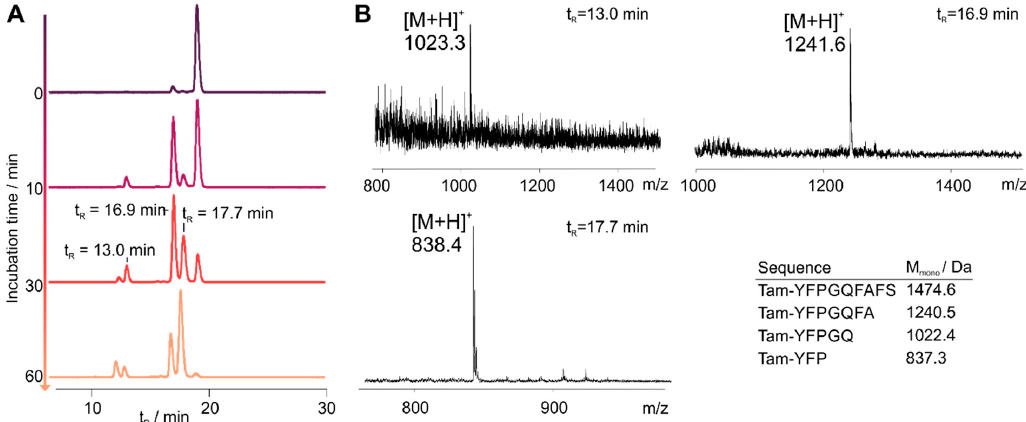
Figure 1. Stability of Tam-chemerin-9 ( 1T ) in human blood plasma. ( A ) RP-HPLC traces of samples Table 573 nm. ( B ) MALDI ToF mass spectrometry analysis of samples taken from the peaks depicted in ( A ).